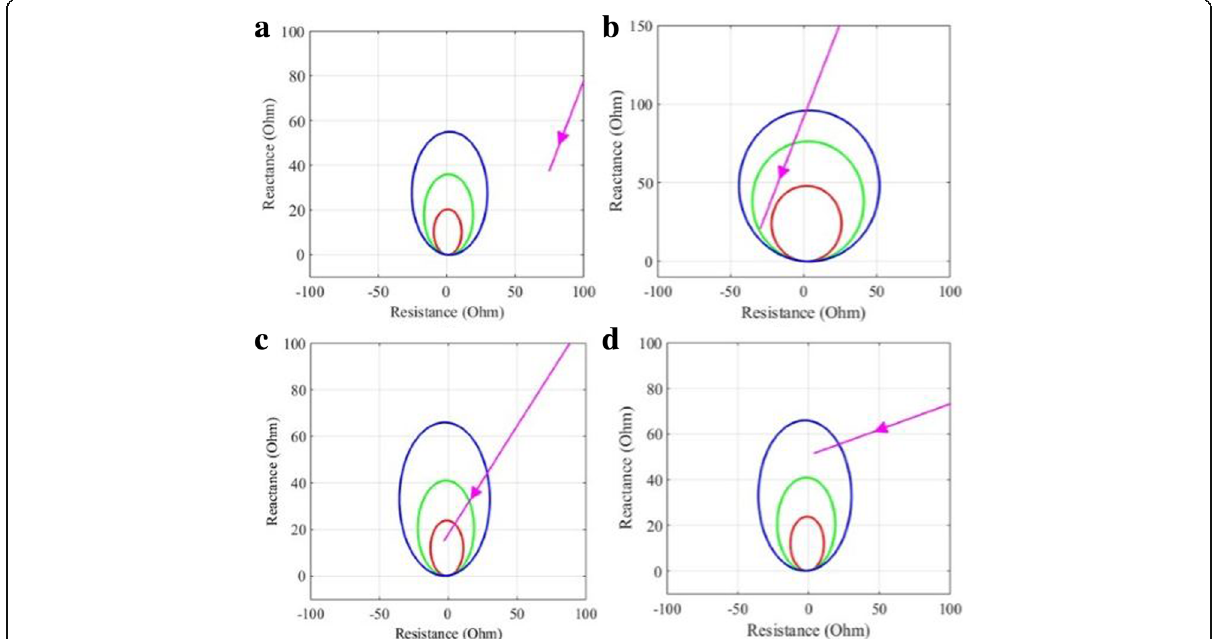
Fig. 5 Impedance trajectory of ( a ) R 13-12 , when LG (70 Ω , 144 0 and 200 km from BUS-13) fault occurred; ( b ) R 7-8 , when LL (50 Ω , 90 0 and 0 km from BUS-7) fault occurred; ( c ) R 2-1 , when LLG (15 Ω , 72 0 and 70 km from BUS-2) fault occurred; ( d ) R 9-10 , when LLL (60 Ω , 0 0 and 65 km from BUS-9)